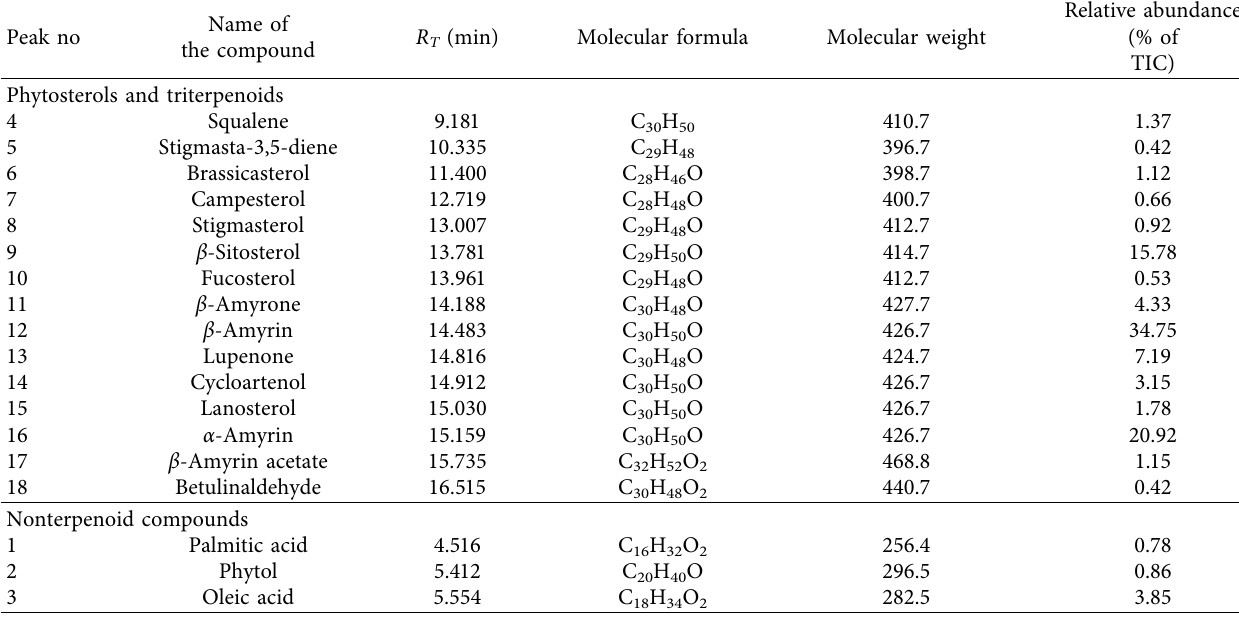
Figure 1: GCMS chromatogram of the saponifed diethyl ether extract of pili pulp oil. Refer to Table 1 for peak identities. Table 1: GCMS profling of the saponifed diethyl ether extract from pili pulp